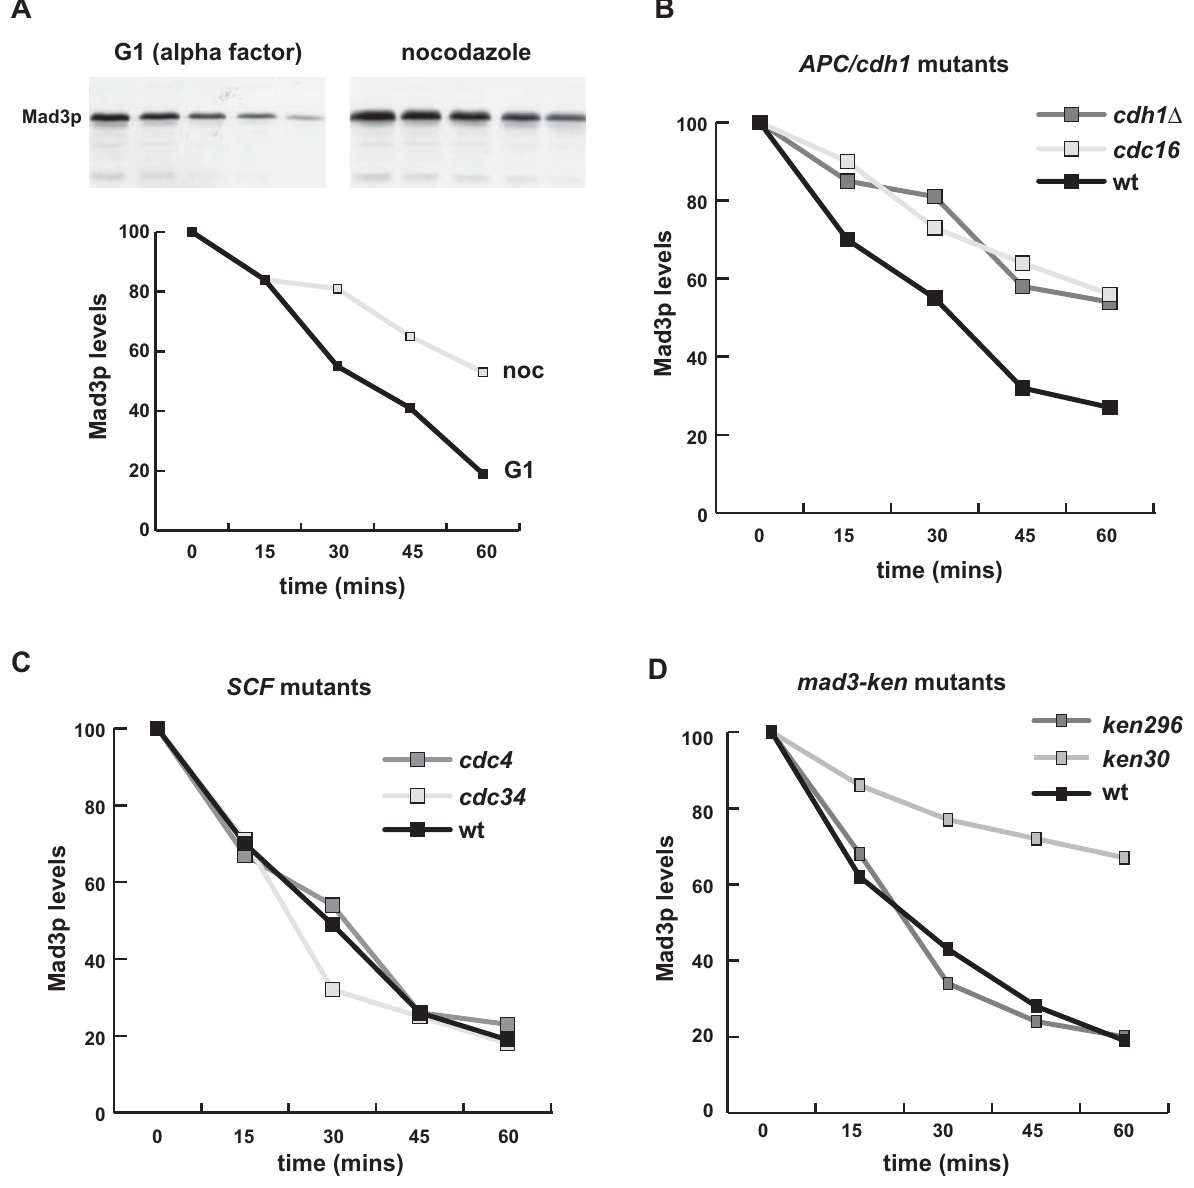
Figure 2. Mad3p is an APC/C substrate. A) Mad3p is unstable in G1. Cells expressing GAL-MAD3 were first synchronised in G1 (with alpha factor) or mitosis (with nocodazole) in raffinose media, and then a pulse of Mad3p expression was induced by 30 minutes of growth in media containing 2% galactose. Cells were then washed with glucose media (YPD) and cycloheximide was added to inhibit new protein synthesis. The G1 and mitotic arrests were maintained, samples taken at the times indicated, and whole cell extracts immunoblotted with anti-Mad3p antibodies to determine the remaining level of Mad3p. B) Mad3p turnover in G1 is APC/C dependent. Cells expressing GAL-MAD3 were synchronised in G1 (with a -factor) in raffinose media, and then a pulse of Mad3p expression was induced by 30 minutes of growth in media containing 2% galactose. Cells were then shifted to 36 u C (restrictive temperature for cdc16 -ts) for 30 minutes, washed with glucose media (YPD) and cycloheximide was added to inhibit new protein synthesis. The G1 arrest was maintained, samples taken at the times indicated, and whole cell extracts immunoblotted with a -Mad3p antibodies to determine the remaining level of Mad3p. C) SCF mutants do not stabilise Mad3p in G1. cdc4 and cdc34 strains expressing GAL-MAD3 were analysed for Mad3p turnover as in B. D) mad3KEN30AAA stabilises Mad3p in G1. mad3 D cells containing GAL driven wild-type or mad3-ken mutants were arrested in alpha factor, and then Mad3p was induced for 30 minutes with galactose media. Cells were then washed in glucose media and cycloheximide was added to prevent new protein synthesis. Samples were taken at the times indicated, and whole cell extracts immunoblotted with anti-Mad3p antibodies for the level of Mad3p.